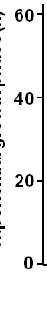
Figure A3. Population doubling time of randomly-selected clones of stable transductants. Randomly-selected 8 clones each from wtCx26 and icCx26 stable transductants as well as 5 clones from mock transductants were subjected to a preliminary cell proliferation assay to measure population doubling time. Each plot corresponds to a single clone. Note that none of the mock clones show native clonal variation. 2 and 1 clones of wtCx26 and icCx26 transductants, respectively, show a population doubling time indistinguishable from that of the mock clones. It has been confirmed that these 3 clones express Cx26 protein at a similar level to that of parental FaDu cells as revealed by immunoblotting. Therefore, omitting the 3 clones, a clone (arrow) indicating a median value was chosen from each of three groups for later experiments. Clonal variation between the clones is due to difference in expression levels of the transgene